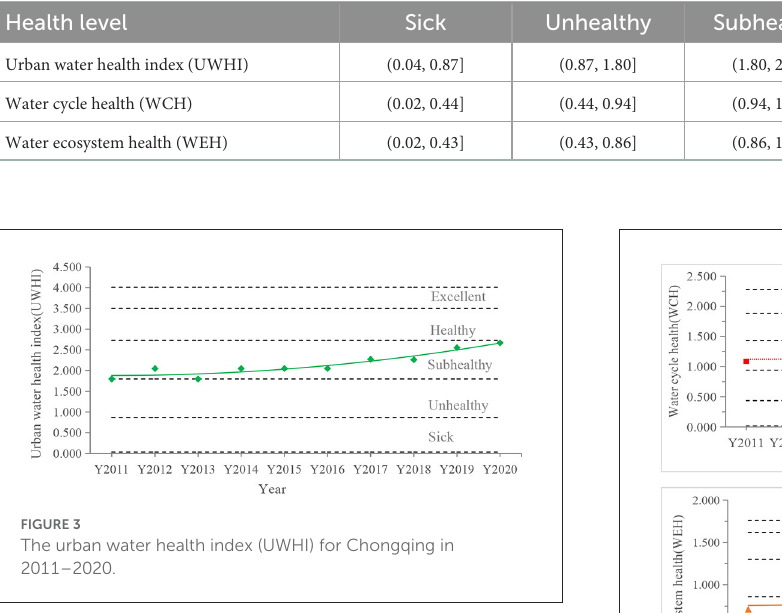
FIGURE4 Water cycle health (up) and water ecosystem health (WEH) (down) of Chongqing in 2011–2020.